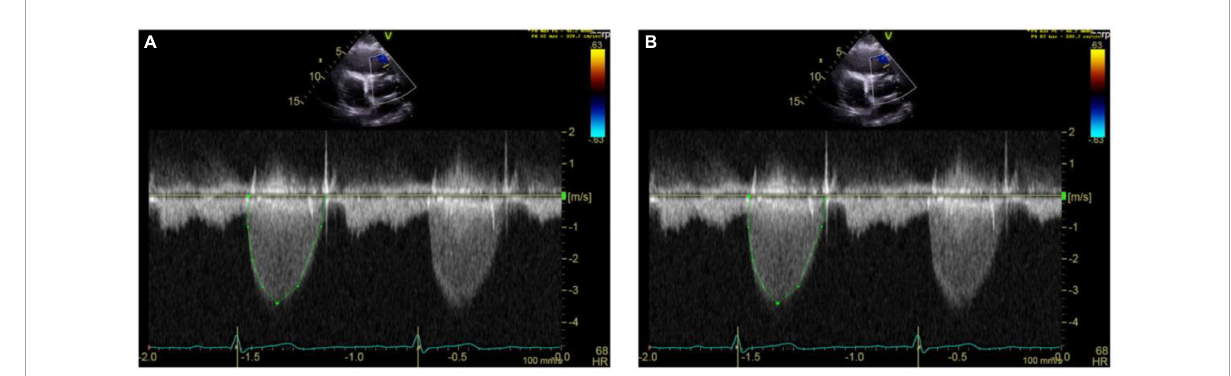
TABLE 4 Follow-up echocardiographic data. Covariate First follow-up